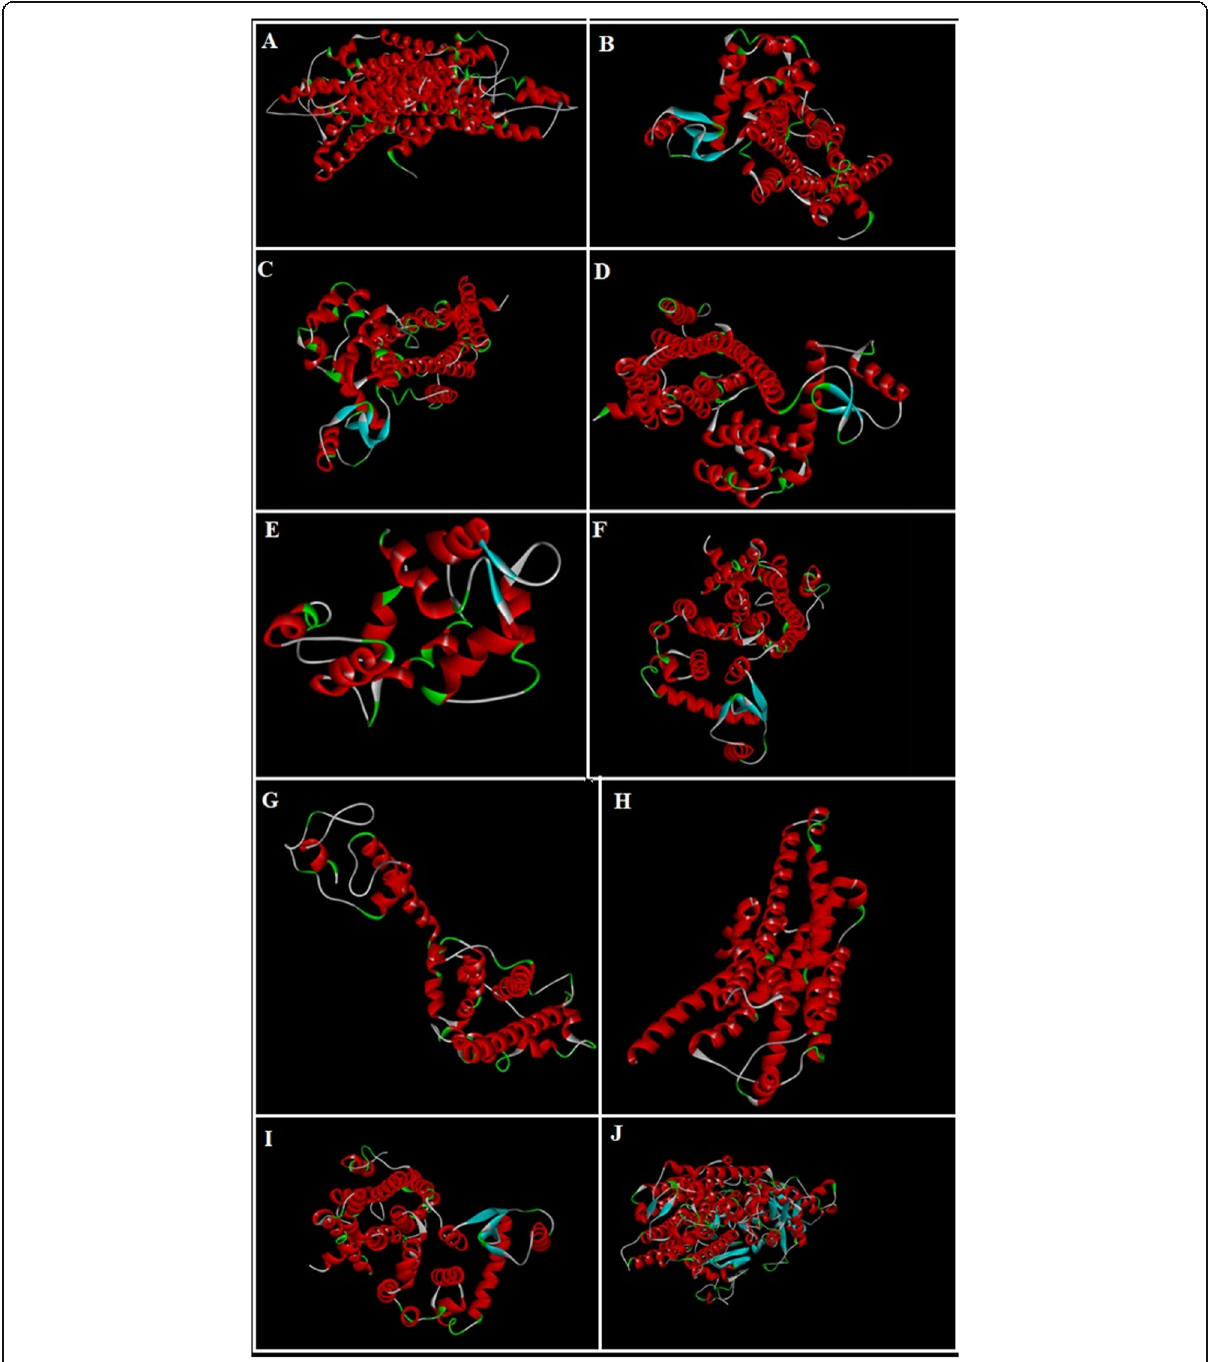
Fig. 2 3D-structures of protein targets: a adrenergic α 1 receptor, b muscranic M 1 , c muscranic M 3 , d dopaminergic D 2 , e calmodulin, f mu-opioid, g voltage gated L-Type calcium channel, h histaminergic H 1 , i histaminergic H 2 , and (j) H + /K + ATPase